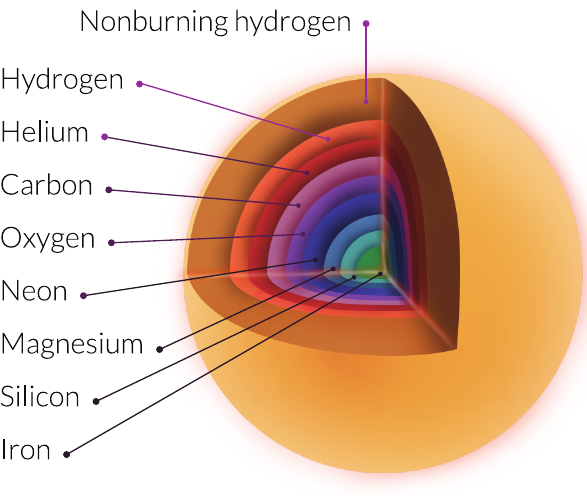
Figure 4. Naive schematic representation of the possible chemical elements synthesized in stellar fusion. Heavier elements are produced in dense stellar matter. Notice that these elements are produced in normal stars, not neutron stars. After a star is born, it takes some time to fuse all the chemical elements in its interior, until its death, which is more or less spectacular depending on its mass. One of the most useful diagrams in the study of stellar evolution is the Hertzsprung and Russel (HR) diagram [16], developed by Ejnar Hertzsprung and Norris Russel independently in the early 1900s. According to the HR diagram, displayed in Figure 5, the star spends most of its life time in the central line of the diagram, the main sequence. Our Sun will become a white dwarf after its death, the kind of objectt shown at lower luminosities and higher temperatures, towards the left corner of the diagram. More massive stars, with masses higher than eight solar masses ( M (cid:12) ) become either a neutron star or a black hole, and these compact objects are not shown in the HR Diagram since they do not emit visible light waves. Moreover, neutron stars were only detected much later, as discussed in Section 2.2. For a better comprehension of the HR diagram, please refer to